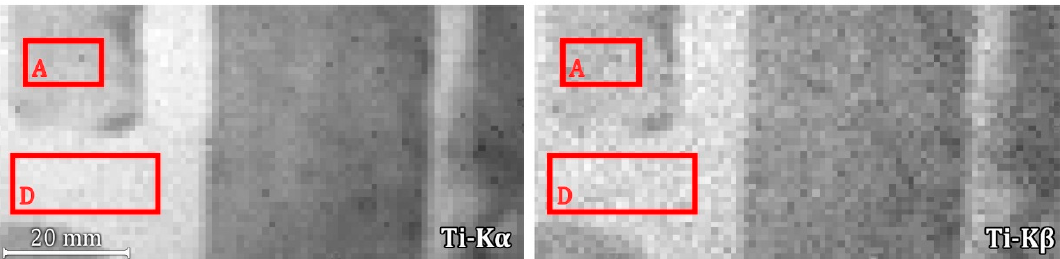
Figure 2. Sampled areas from region A and region D for measuring the Ti matrix thick ratio